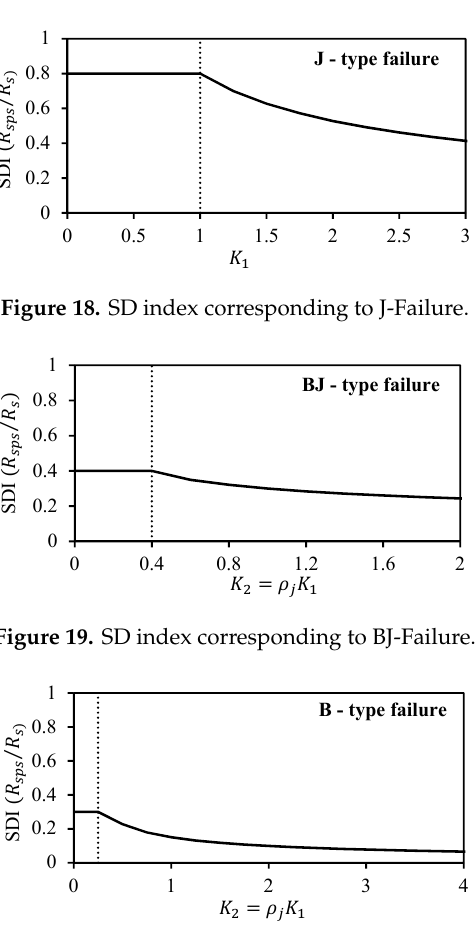
Figure 19. SD index corresponding to BJ-Failure Figure 20. SD index corresponding to Figure 20. SD index corresponding to B-Failure